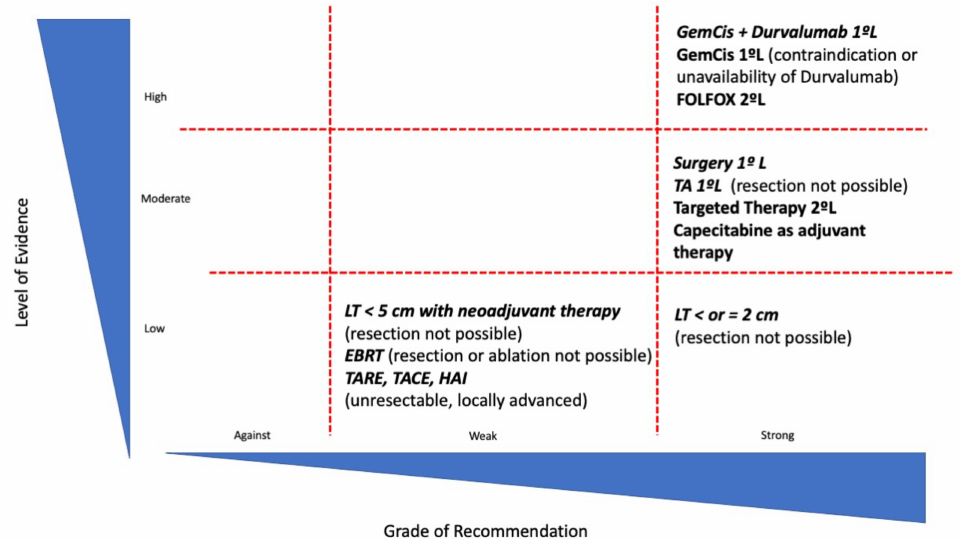
Figure 1. Representation of current treatments in CCA according to levels of evidence and strength of recommendation. TA: Thermal ablation; GemCis: Gemcitabine and Cisplatin; LT: Liver transplanta- tion; EBRT: external beam radiotherapy; TACE: Transarterial chemoembolization; TARE: Transarterial radioembolization; and HAI: chemotherapy hepatic arterial